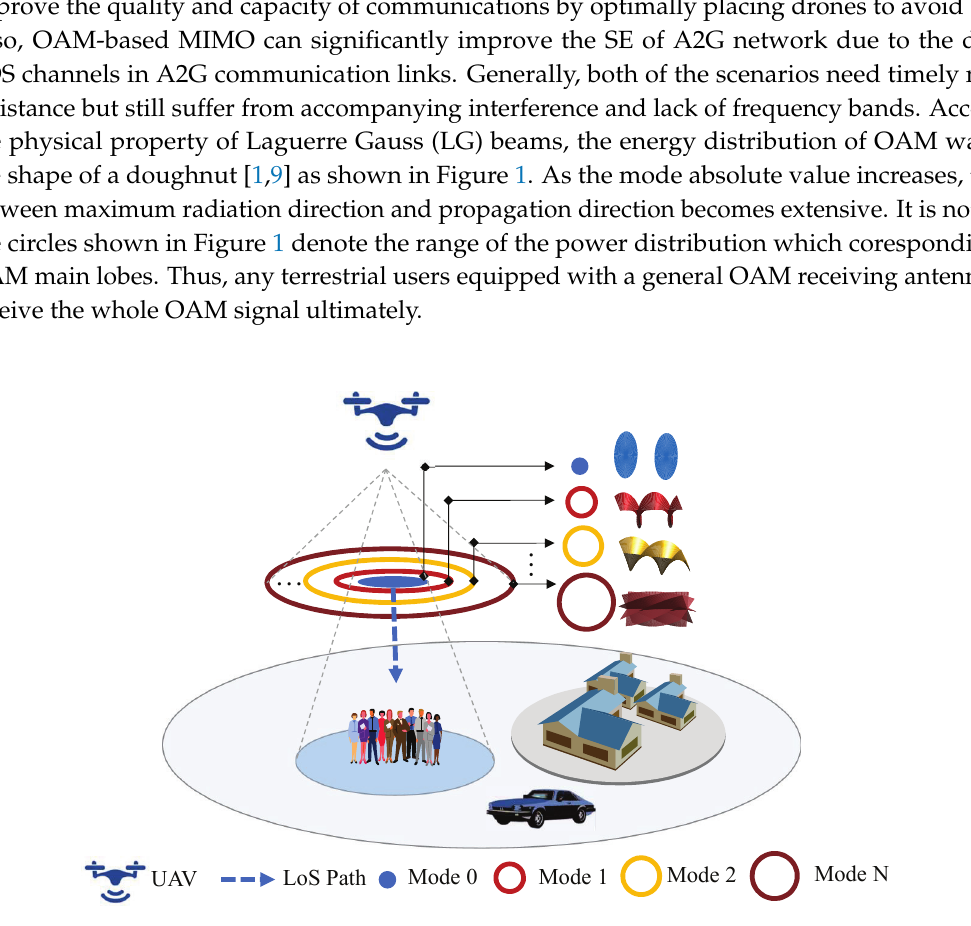
Figure 1. The scenario of the UAV-based radio vortex wireless